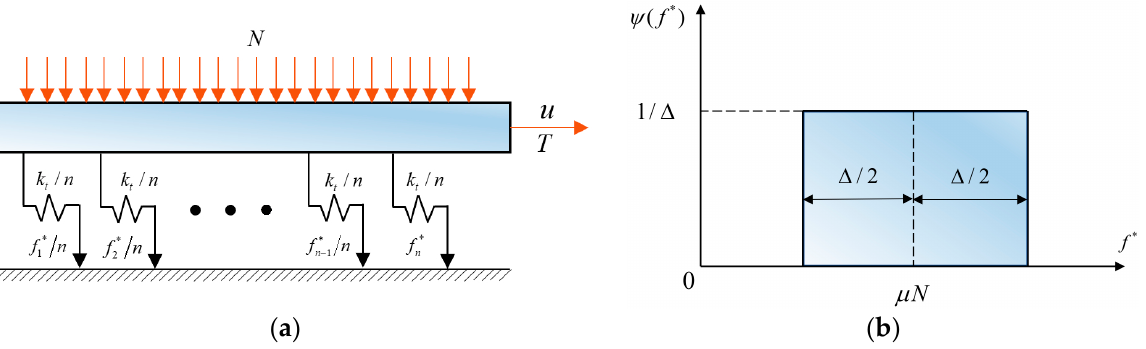
Figure 2. ( a ) The classic Iwan model. ( b ) Density function of the critical sliding force. Once the parameters of the Iwan model have been identified, the discrete form of the backbone curve can be deduced as follows